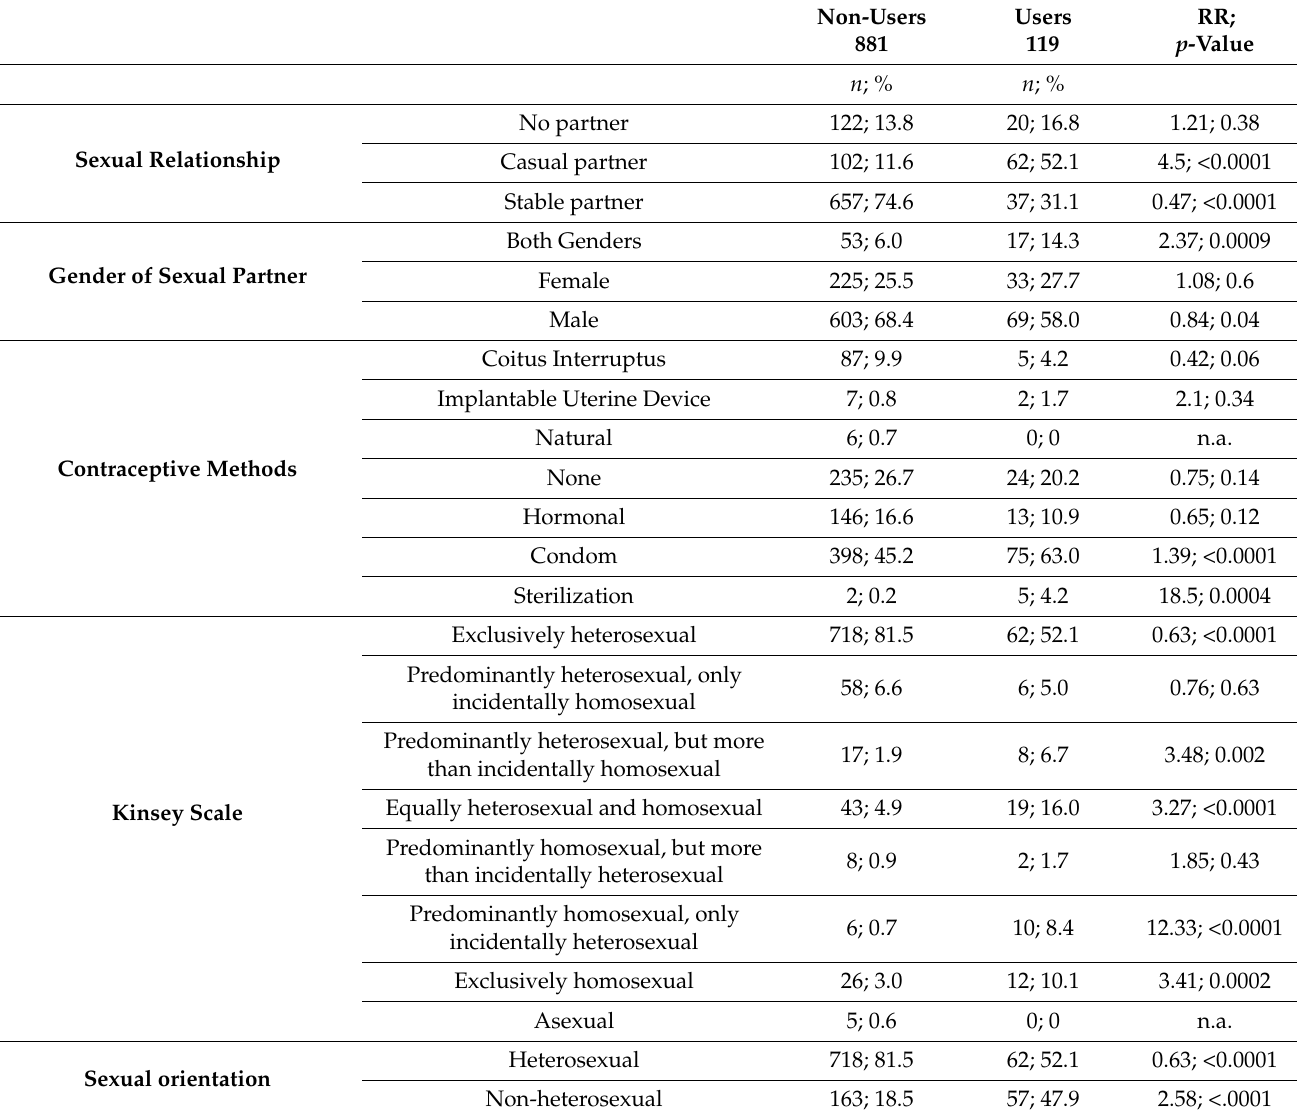
Table 2. Sexual behavior in DA users and